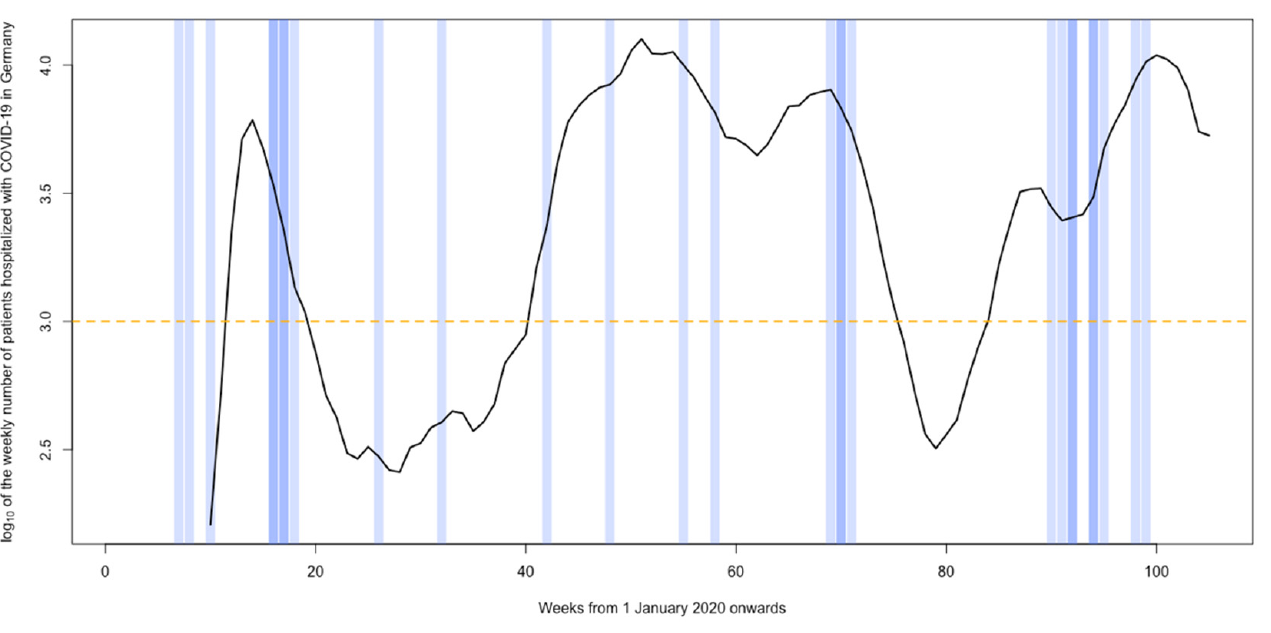
Figure 2. Logarithmic depiction of the weekly number of patients hospitalized with COVID-19 in Germany (PHCG) from 1 January 2020 onwards (black curve). Weeks with more than 1000 PHCG were defined as high COVID-19 caseload weeks (HCLW, black curve above the dashed orange line). Weekly numbers of neurotrauma patients admitted to University Hospital Marburg from the southwestern margin (SWM) of the hospital’s contiguous neurotrauma catchment area varied between 0 (white background), 1 (light blue background), and 2 (blue background). During HCLW, the number of neurotrauma patients admitted from the SWM was significantly higher compared to the time prior to the pandemic and between HCLW (chi-square test; p = 0.003). Statistics were computed and figures were created with RStudio version 2022.02.3